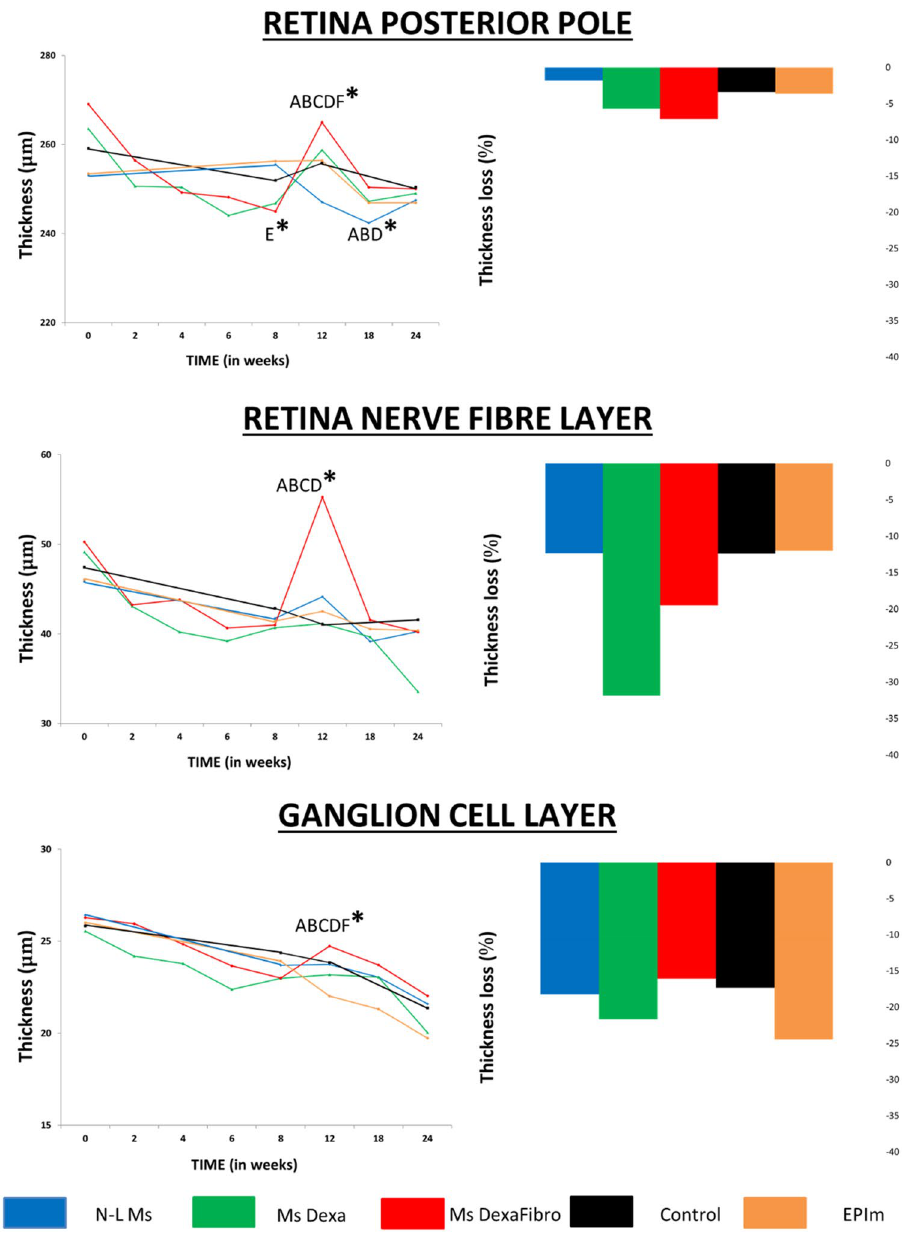
Figure 4. Comparison of structural neuroretinal studies using optical coherence tomography (OCT) between four chronic glaucoma models and healthy control cohorts Left: Neuroretinal thickness measured using OCT over 24 weeks. Right: Neuroretinal thickness loss percentage at the end of the study. % : percentage; μm thickness in microns; N-L Ms cohort with non-loaded microspheres; MsDexa cohort with microspheres loaded with dexamethasone; MsDexaFibro cohort with microspheres loaded with dexamethasone and fibronectin; EPIm cohort with sclerosis of the episcleral veins; *: statistical significance ( p < 0.05) between glaucoma models and healthy controls (ANOVA); A: significant differences between N-L Ms and MsDexa; B: significant differences between MsDexa and MsDexaFibro; C: significant differences between MsDexa and controls; D: significant differences between MsDexa and EPIm; E: significant differences between MsDexaFibro and controls; F: significant differences between MsDexaFibro and EPIm; by Scheffé